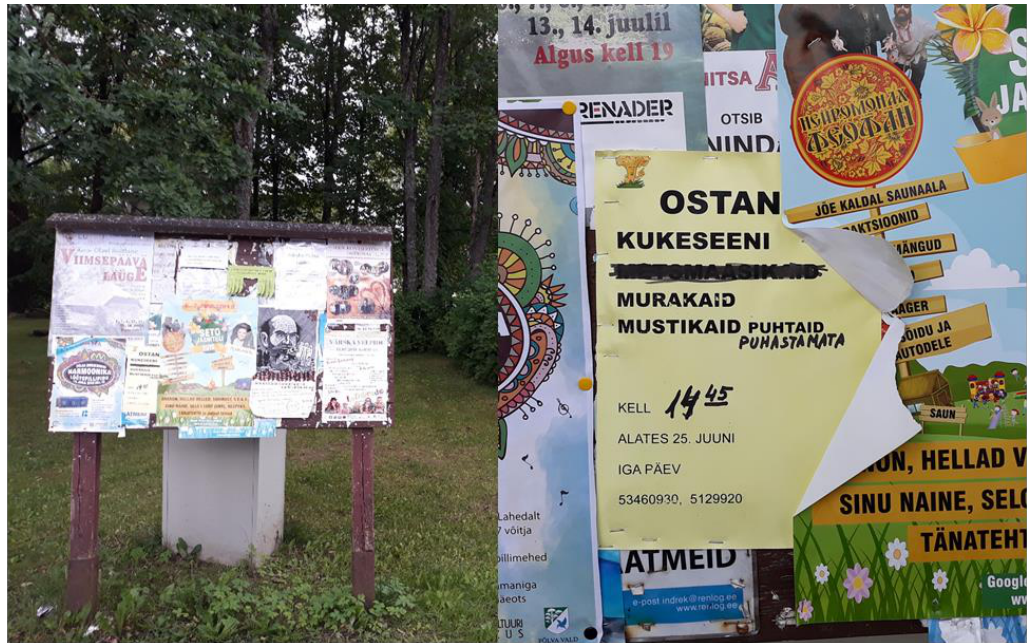
Figure 5. Message board in Orava village: “Every day from 25 June, I buy chanterelles, cloudberries, bilberries”. Photos: Renata Sõukand 7 July 2018.